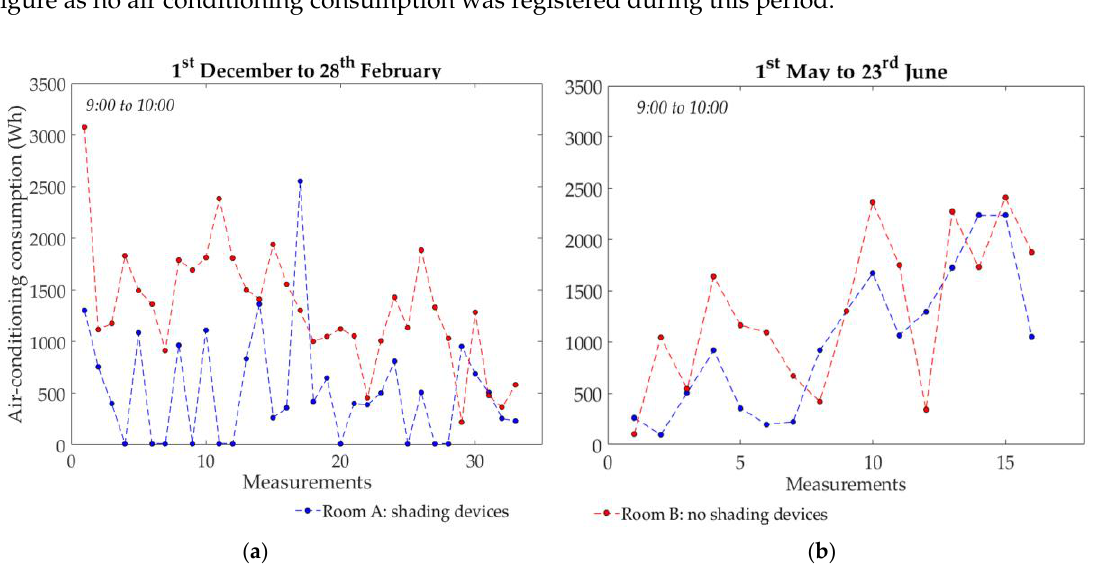
Figure 5. Analysis of the hours in which both classrooms simultaneously recorded air conditioning consumption, during the first hour of class (9:00 to 10:00): ( a ) winter and ( b ) summer.